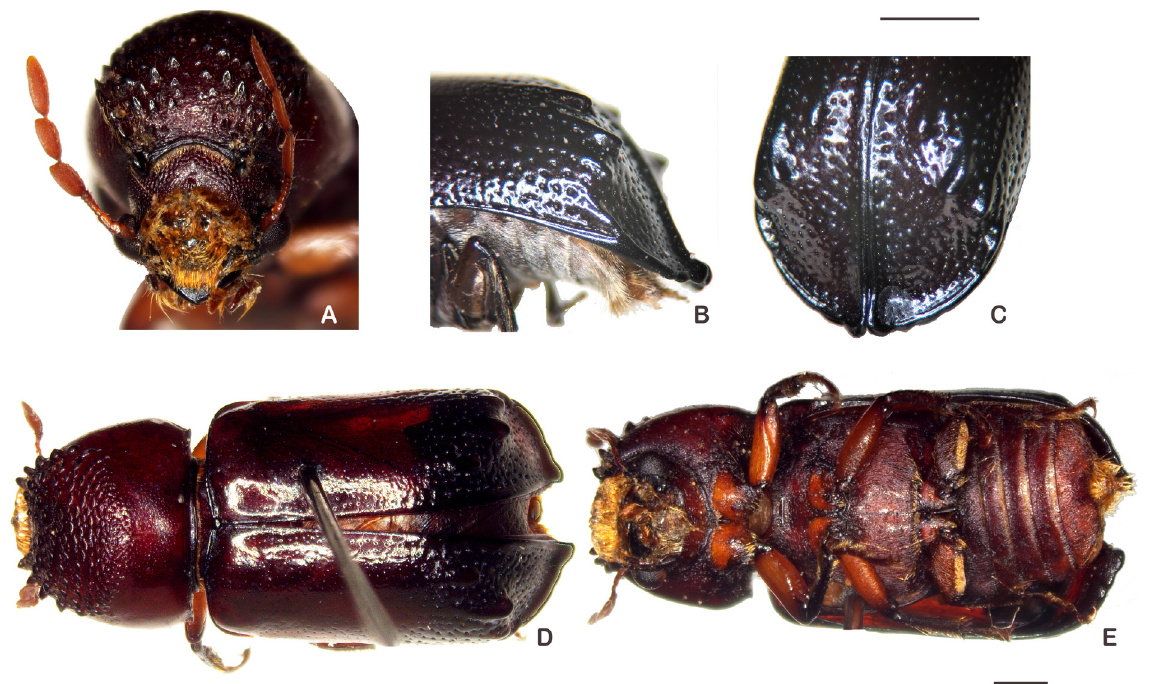
Fig. 2. Xylothrips flavipes (Illiger, 1801), ♀ (LYL). A . Frontal view. B . Lateral view of declivity. C . Declivity. D . Dorsal view. E . Ventral view. Scale bars = 1 mm (upper scale for A–C; lower scale for